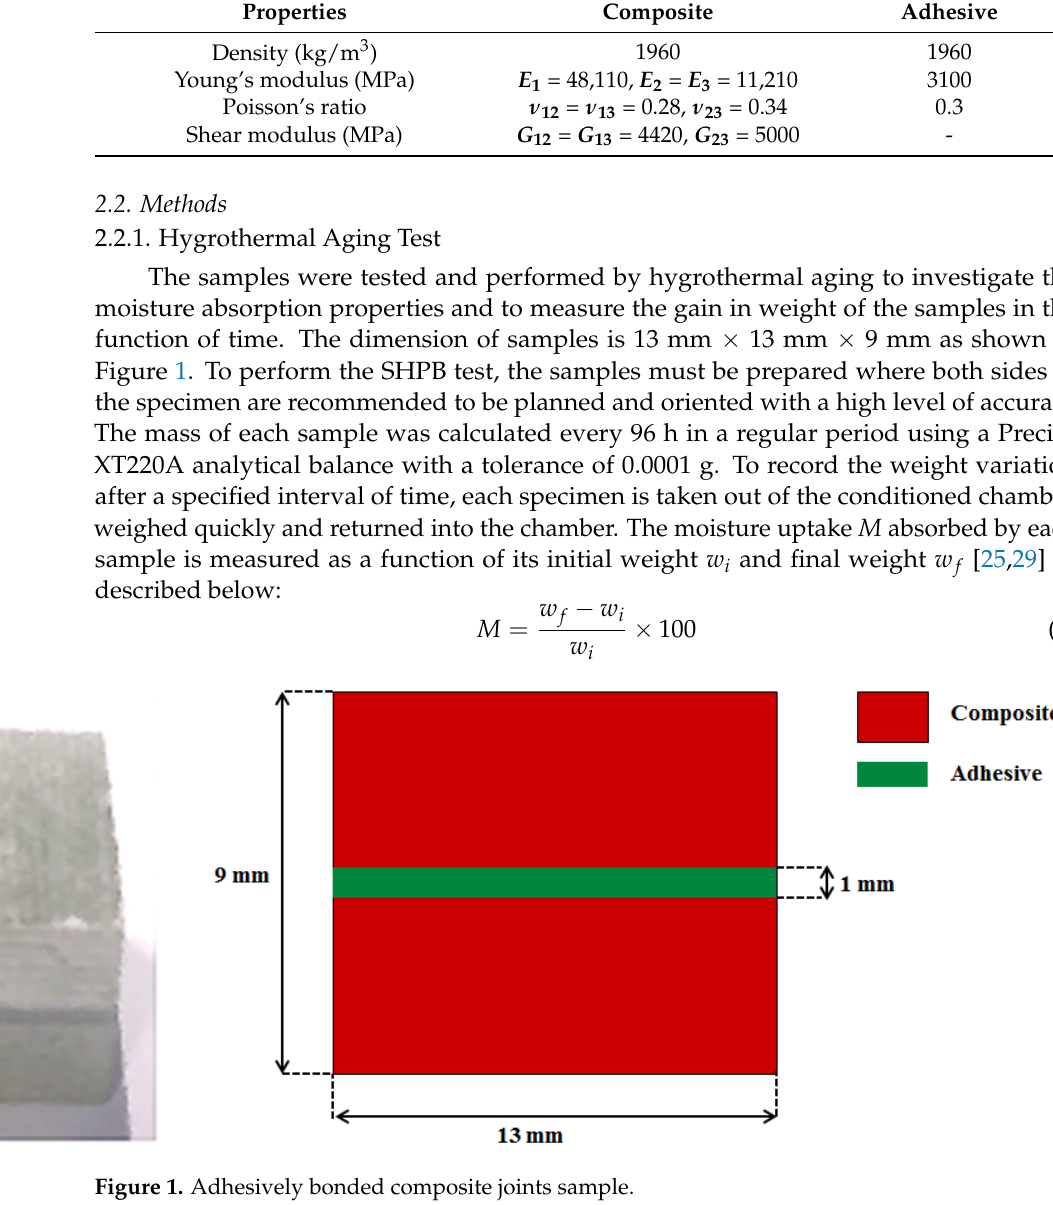
Table 1. Composite and adhesive mechanical properties.